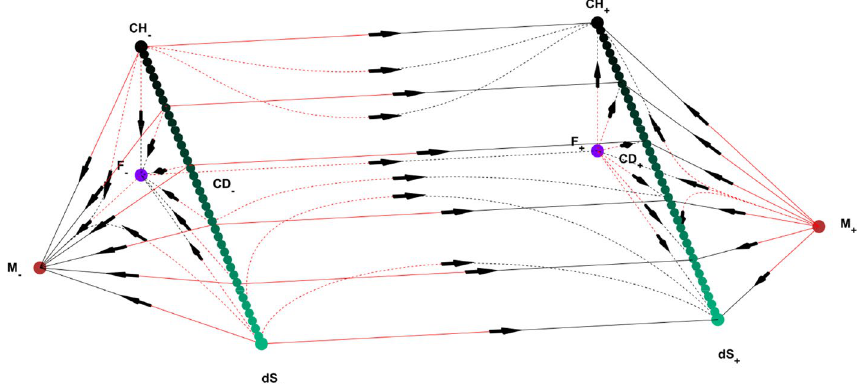
1 and γ < 2 Figure 2. State space for α 3 . Here, dots denote the solutions of the system; = 1, � � 0, � A 0, k 0 ) , Milne F, M, dS, CH and CD represent Flat FL solution (� = = = = 0, � � 0, � A 0, k 1 ) , de Sitter solution (� 0, � � 1, � A 0, k 0 ) , solution (� = = = = − = = = = 1, � � 0, � A 0 ) and Chaplygin-de Sitter solution line 1 √ γ , k α Chaplygin Gas solution (� + = = = = 1 0 ) , respectively. z axis corresponds to (cid:31) A for all of the state space. (� � , � � � , � A 1 √ γ� , k α + = = − = = 1 1 region (middle) vertical and horizontal axes correspond to (cid:31) and Q , respectively. On k On k = − = + region (triangular parts on both sides), M-F and M-dS lines correspond to (cid:31) and (cid:31) (cid:30) axes, respectively. The right and left parts of the state space represent expanding and contracting universes, respectively. Subscripts on equilibriums refer to the sign of H there. Lines go from red to black. (MATLAB ver.